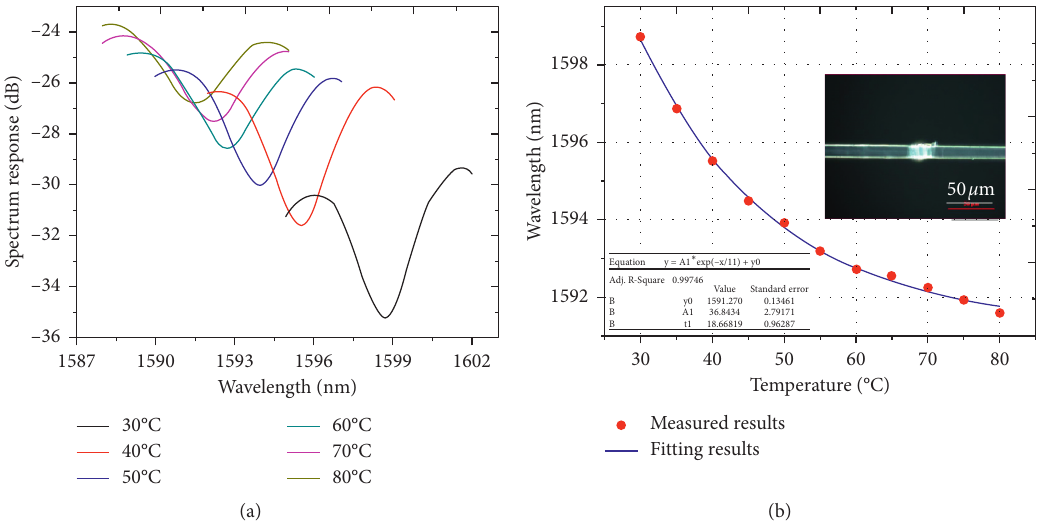
Figure 6: (a) Transmission spectrum of LPMFGs at different temperatures ranging from 30 ° C to 80 ° C; (b) corresponding relationships between temperature and the dip wavelength shift and the optical microscope image of modification zone of fabricated LPMFGs as shown in the